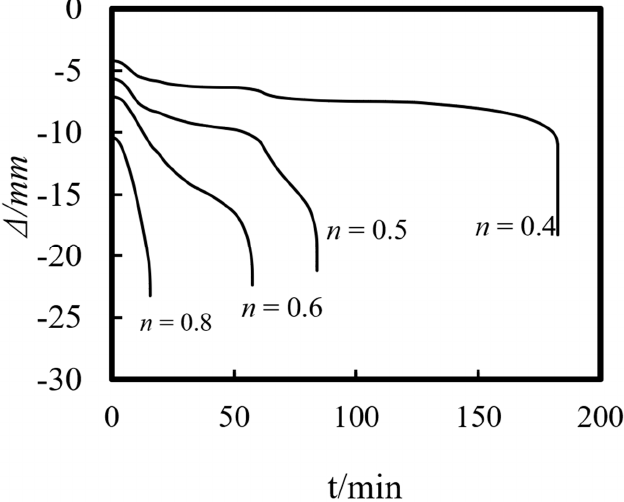
Figure 15. Effect of load ratio on the axial deformation–time curve.